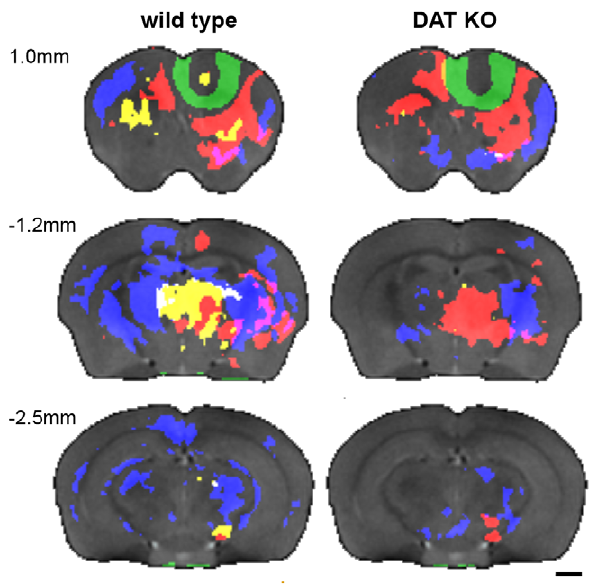
Figure 4. Coronal sections of statistical parametric maps show the progression of Mn 2 + accumulation over time. Representative coronal sections through the statistical parametric maps show the progression of Mn 2 + accumulation over time. Gray background is pre- injection MDT, while the green (1 hr . pre-injection), red (4 hr . 1 hr), yellow (8 hr . 4 hr) and blue (26 hr . 8 hr) overlays indicate areas with increased intensity (P , 0.00025) compared to the preceding time point. Video in Supplemental Data shows the complete image data sets in for each genotype (Video S1). Slice locations are indicated relative to Bregma. Scale bars =1 mm.